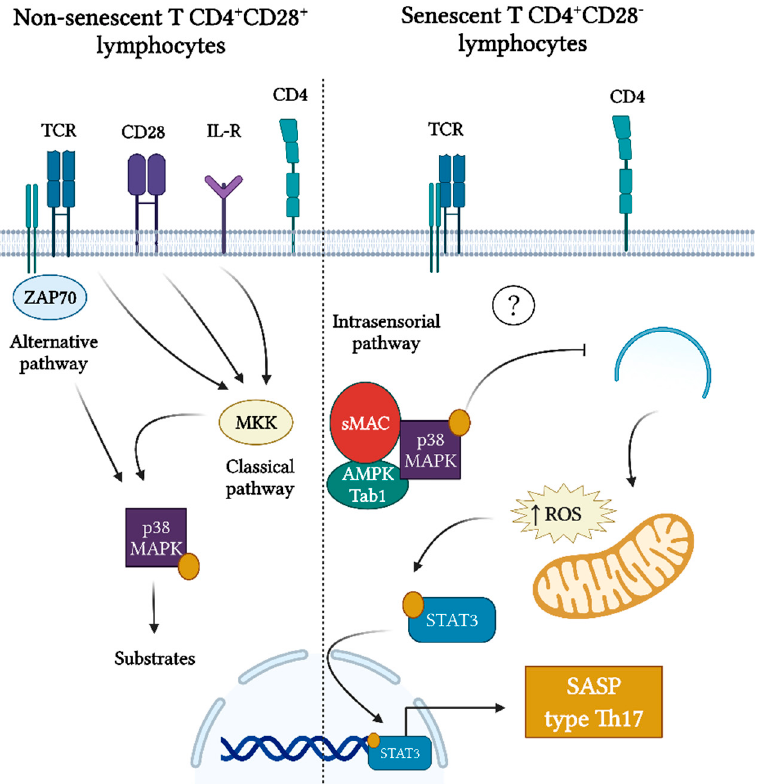
Figure 6. Activation of p38 MAPK in senescent CD4 + CD28 - T lymphocytes and its potential to drive a Th17-type SASP. Activation of p38 mitogen-activated protein kinase (p38 MAPK) in non-senescent CD4 + T lymphocytes can respond to two signaling pathways: classical and alternative. The classical signaling pathway can be activated by cytokines or by engagement of the T cell receptor (TCR) and the costimulatory molecule CD28 and depends on an upstream kinase cascade that relies on mitogen-activated protein kinase kinase (MAPKK) activation. In contrast, the alternative signaling pathway is activated by TCR engagement and depends on zeta chain-associated protein kinase 70 (ZAP70). However, senescent CD4 + CD28 - T lymphocytes lack MAPKK and ZAP70 but show constitutive p38 activation, which responds to an intracellular sensory mechanism in response to DNA damage and is dependent on the AMP-activated protein kinase (AMPK)-Tab1 and sestrin-MAPK activation complex (sMAC). It has been observed that p38 MAPK is able to inhibit autophagy and lead to the accumulation of dysfunctional mitochondria, with the consequent increase of reactive oxygen species (ROS). In CD4 + T lymphocytes of elderly individuals, it has been shown that this process leads to the activation of the signal transducer and activator of transcription (STAT)-3, responsible for the production of a Th17 profile of cytokines.